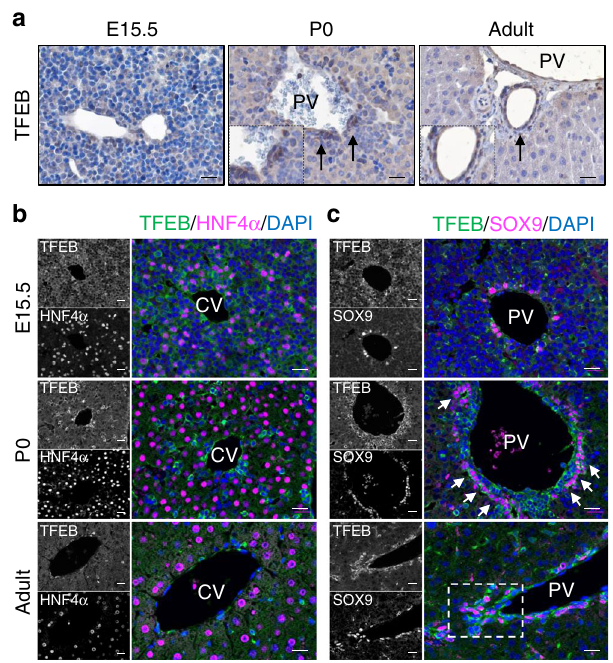
Fig. 1 TFEB expression is enriched in ductal/progenitor cells. a Immunohistochemistry analysis of TFEB in wild-type (WT) liver at the indicated stages showing prominent signaling in bile ductules. Arrows indicate ductal cells. b , c Representative immuno fl uorescence stains for TFEB/HNF4 α ( b ) and TFEB/SOX9 ( c ) showing TFEB levels in the central (CV) and in the portal (PV) vein area. Scale bar 20 μ m. Micrographs are representative of fi ve mice of each